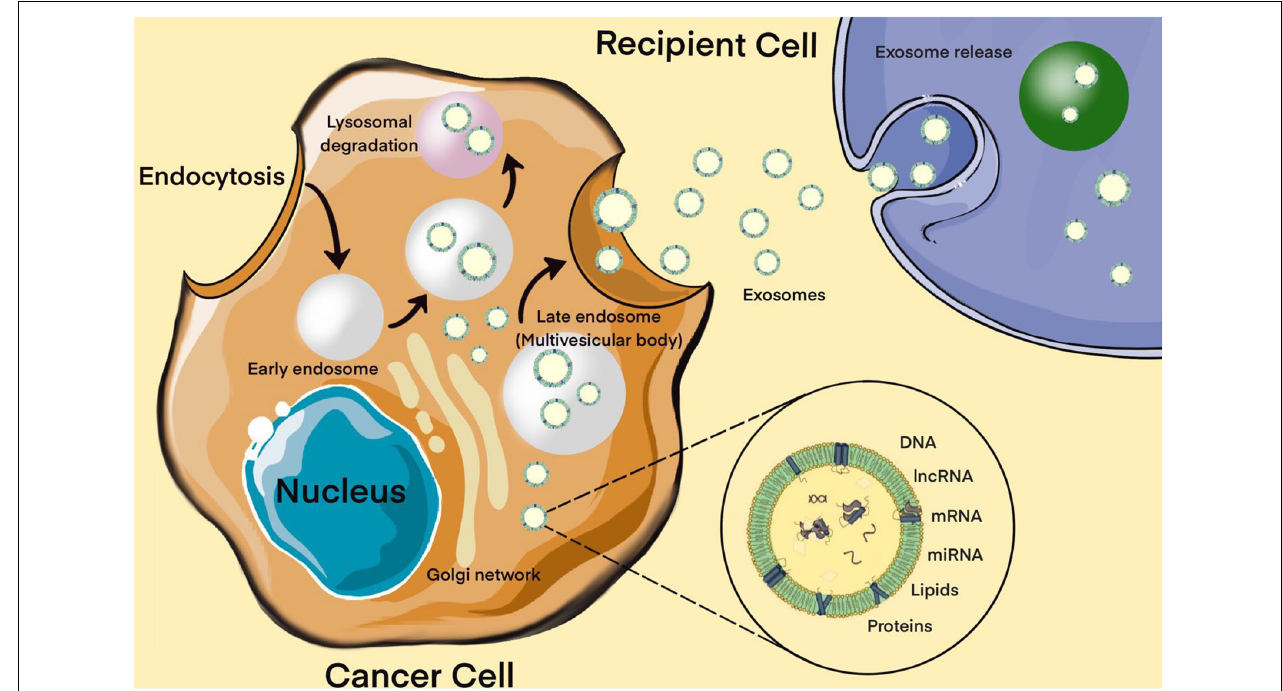
FIGURE 4 | Biogenesis of exosomes. The exosome membrane is formed as a result of the invagination of the early endosome into the membrane. Proteins, lipids, RNA, DNA enter the exosome from the cell cytoplasm. The fate of an endosome depends on the marking of its membrane with certain lipids: if it is labeled with lysobisphosphatidic acid, then its contents will be destroyed, and if ceramides, it will be pushed out of the cell. These processes are controlled by the GTPases of the Rab (G-protein) family, whose various members perform different functions: Rab5 directs the formation of the endosome, Rab7 organizes the degradation of the contents of the multivesicular body (late endosome) in the lysosome, and Rab11, Rab27, and Rab35 are necessary for the secretion of exosomes into the extracellular space. It has been shown that exosomes contain about 4,000 different proteins, more than 1,500 different miRNAs and mRNAs, as well as DNA. Bottom right – enlarged “generalized”